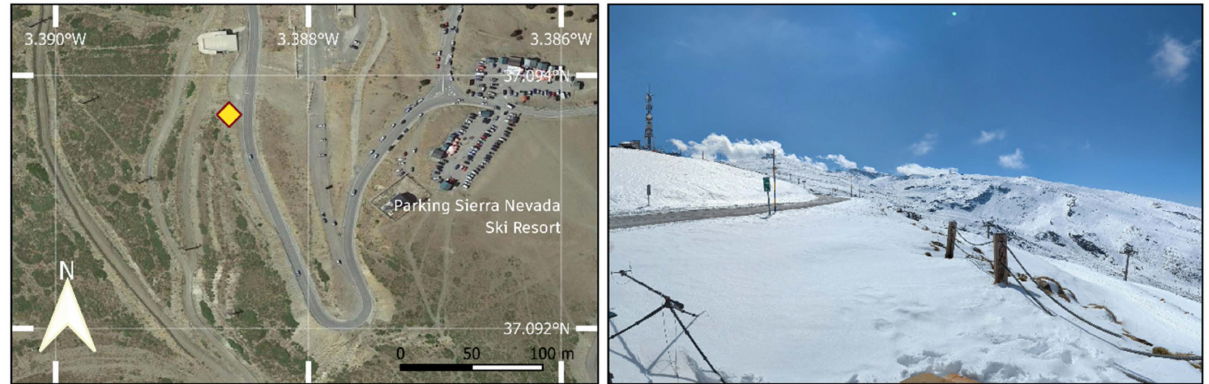
Figure 1. Location of the experimental site ( left ) and south view from the site ( right